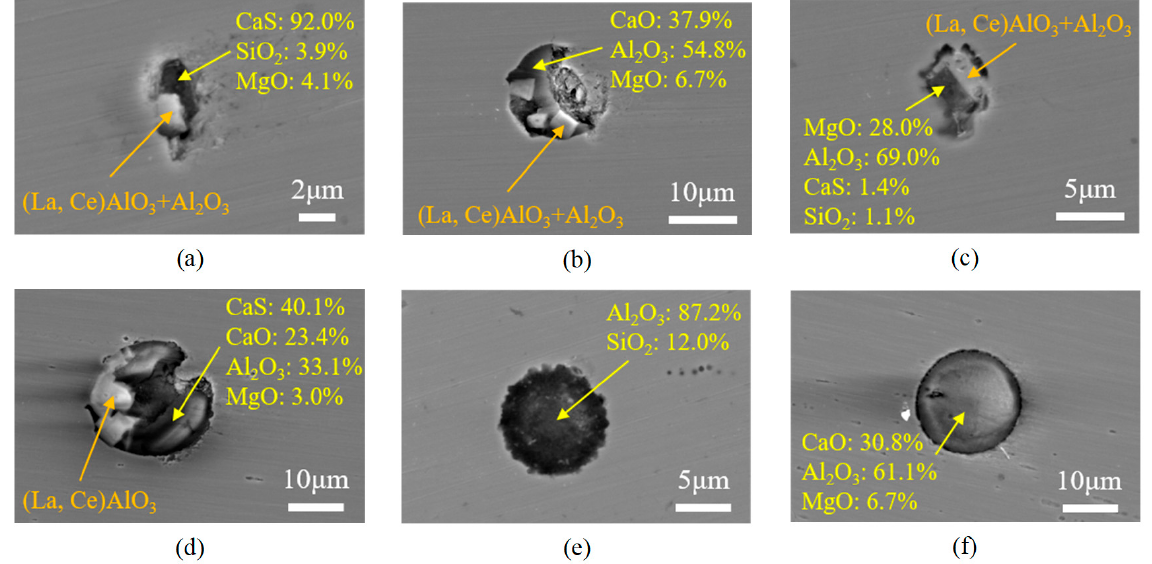
Figure 4. Typical morphologies and compositions of inclusions in the steel at the end of the RH refining process. ( a ) (La,Ce)AlO 3 +Al 2 O 3 +MgO-CaS-SiO 2 ; ( b ) (La,Ce)AlO 3 +Al 2 O 3 +Al 2 O 3 -CaO-MgO; ( c ) (La,Ce)AlO 3 +Al 2 O 3 +Al 2 O 3 -MgO-CaS-SiO 2 ; ( d ) (La,Ce)AlO 3 +Al 2 O 3 -CaO-MgO-CaS; ( e ) Al 2 O 3 - SiO 2 ; ( f ) Al 2 O 3 -CaO-MgO.